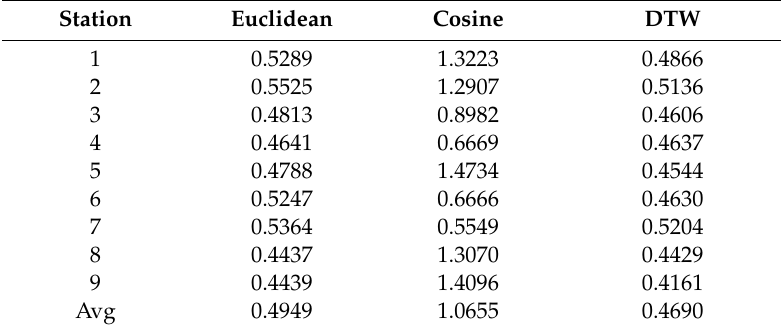
Table 2. RMSE obtained by predicting SST with three similarity measures.